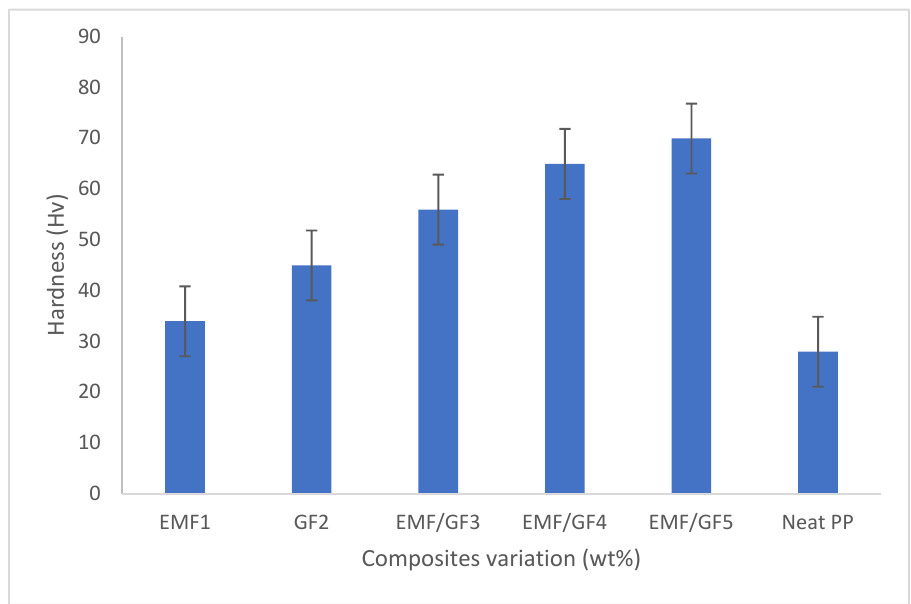
Figure 10. Microhardness of the single and hybrid composites.